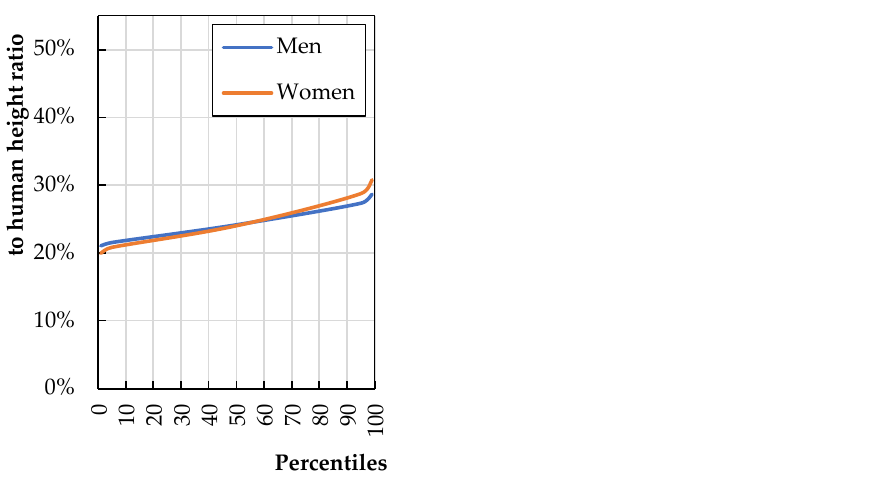
Figure 7. Elbow-to-elbow breath ( D ) to total human stature ( H ) (calculations based on literature data [20]).